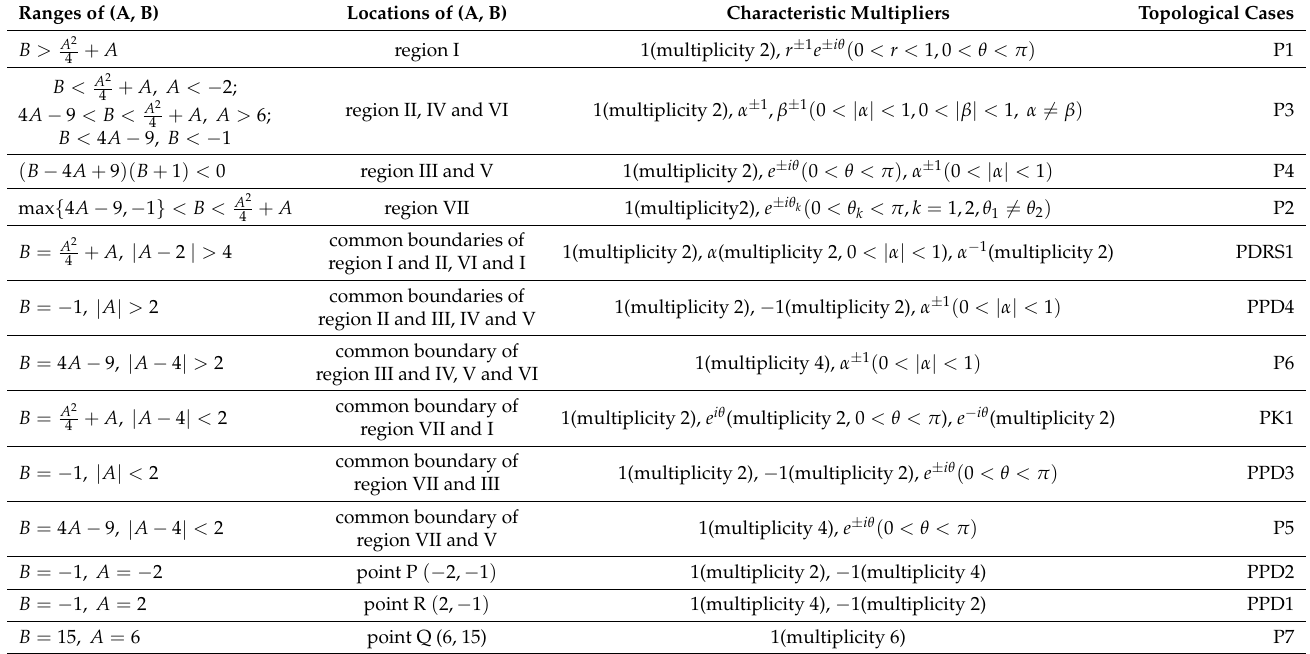
Table 2. Topological classifications of periodic orbits by the locations of parameters (A, B), the 13 topological cases: P1–P7, PPD1–PPD4, PDRS1, PK1 [25]. Characteristic Multipliers Topological